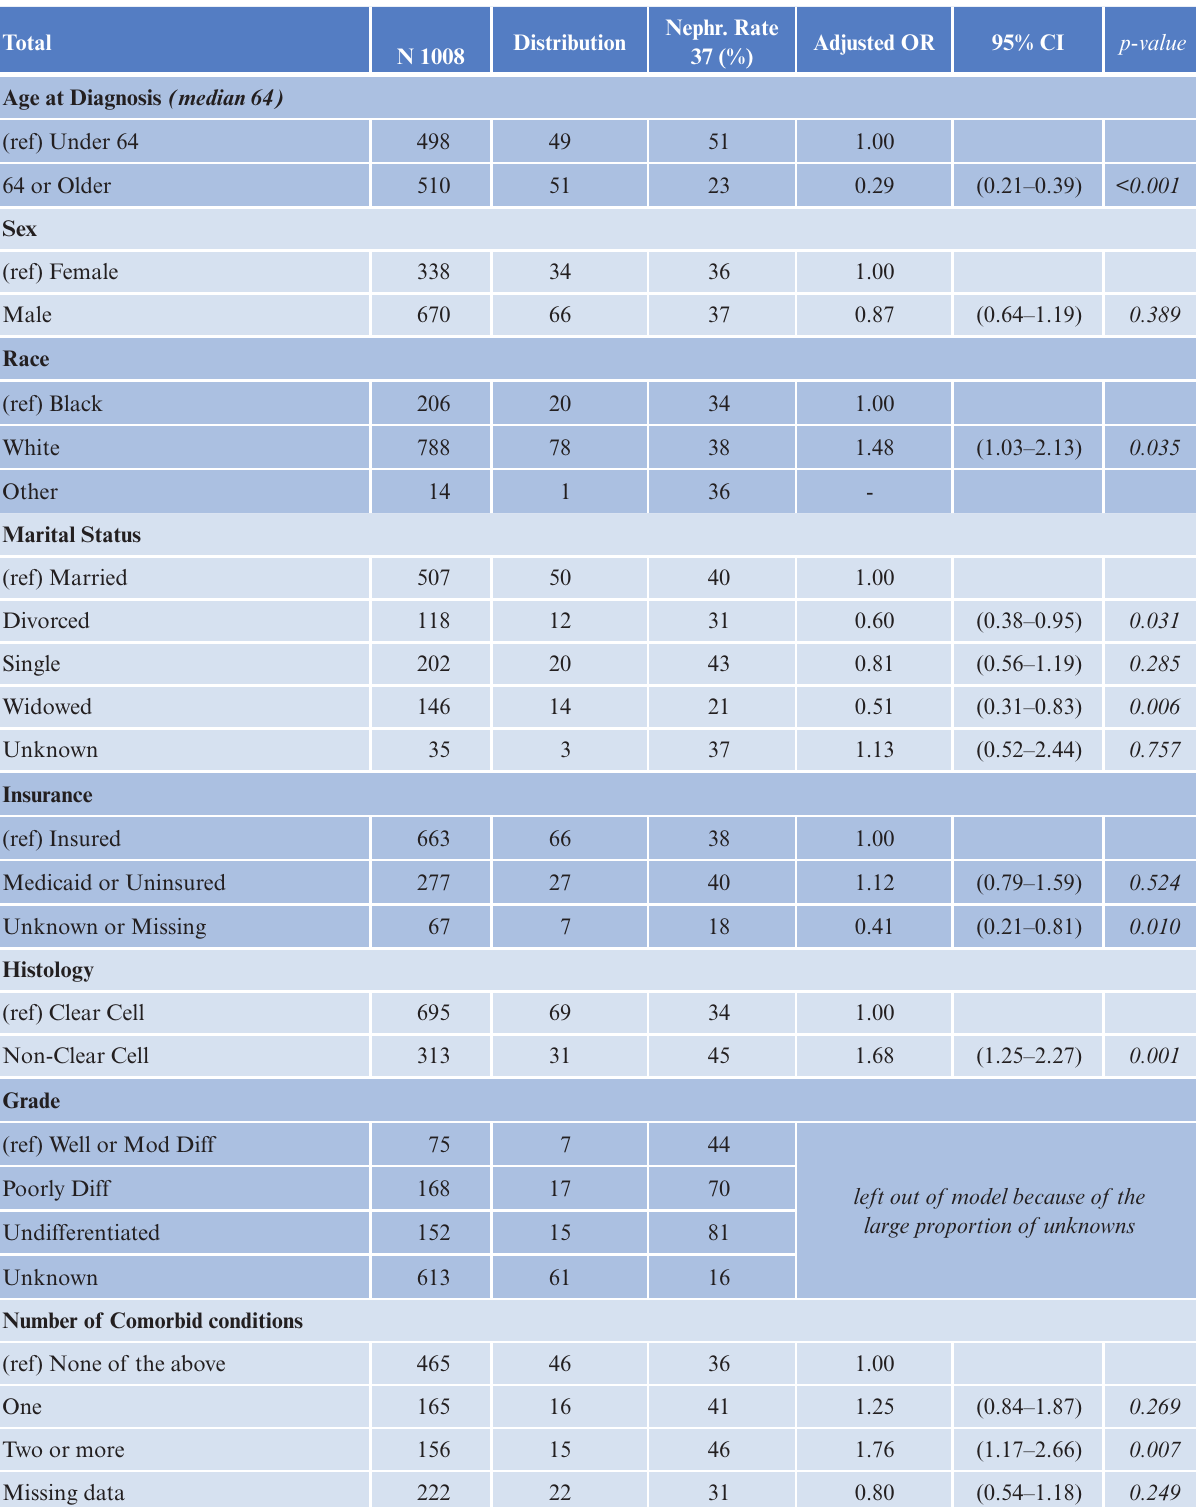
Table 4: Metropolitan Detroit Distant Stage Kidney Cancer: 2000–2013 Odd Ratios for Likelihood of Nephrectomy. Total N